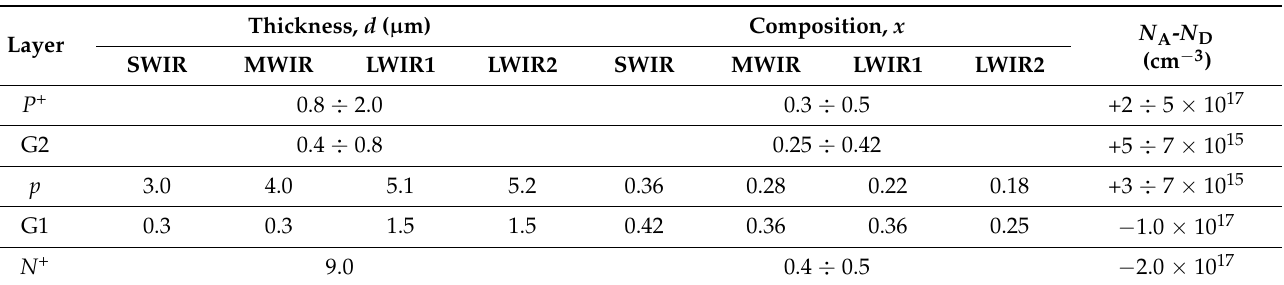
Table 1. Thickness, molar composition, and dopant concentration of individual layers of the SWIR, MWIR, and LWIR detector structures.